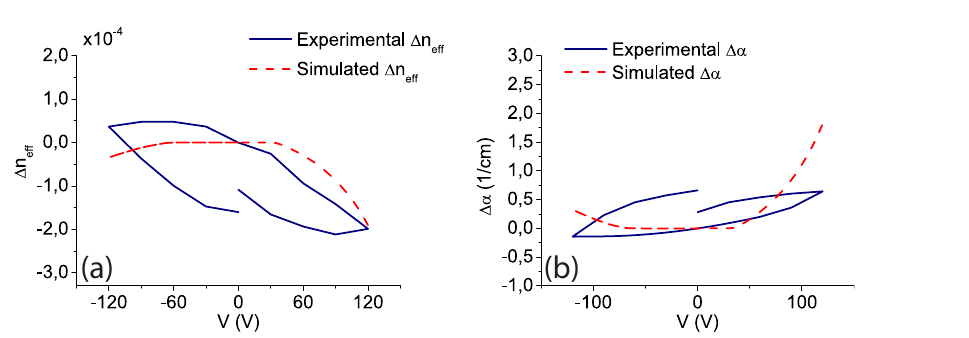
Figure 3. Simulation and experimental results comparison. The simulated ( a ) refractive index change and ( b ) absorption have been obtained taking into account the interface traps parameters depicted in Table